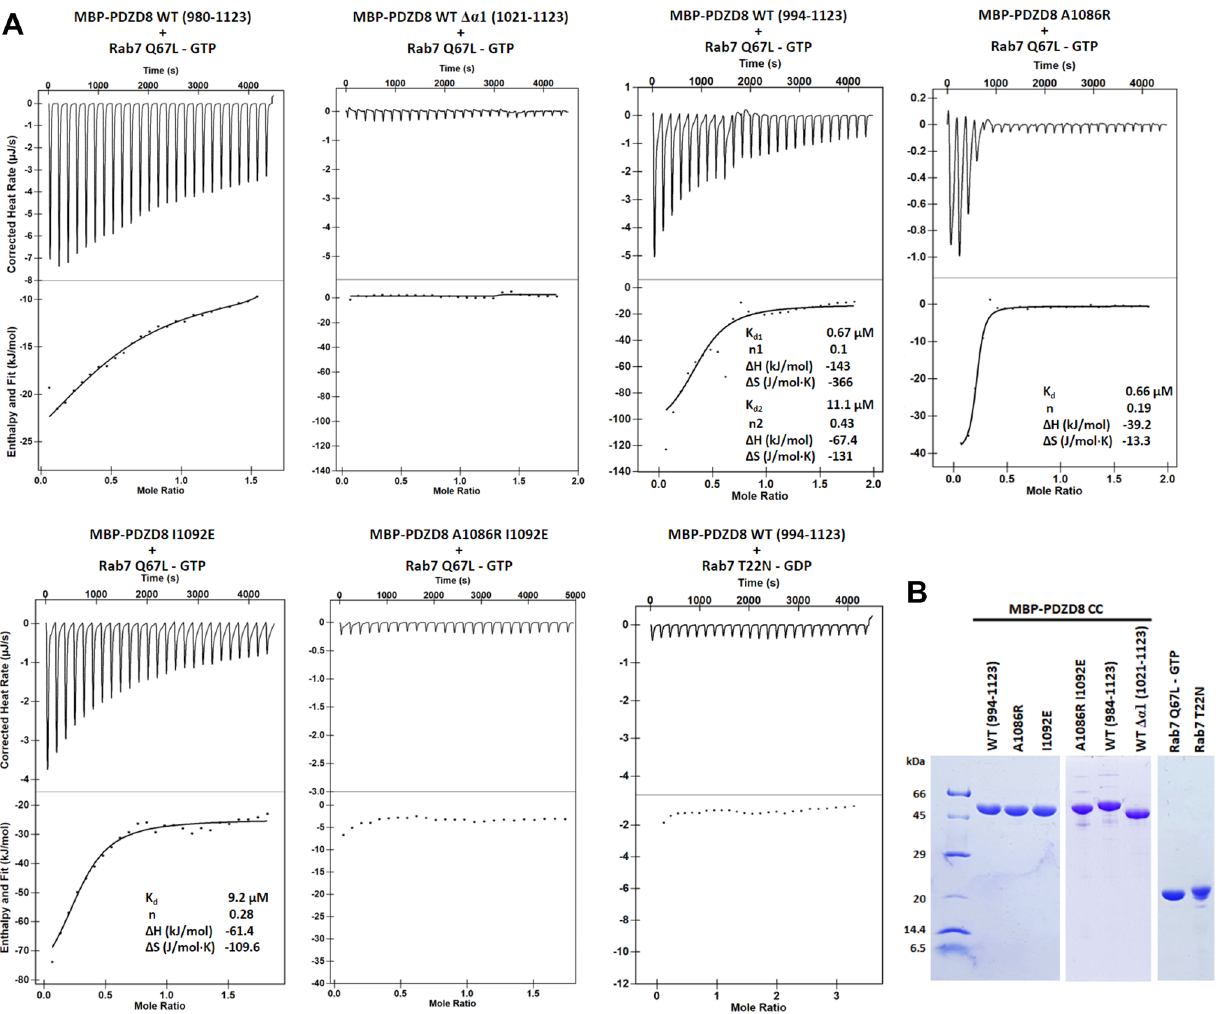
Figure 3. Affinity measurement of the PDZD8 CC and Rab7 interaction. ( A ) Measurement of binding affinity of the PDZD8 CC to Rab7 by isothermal titration calorimetry. Rab7 with a concentration of 0.1 mM was titrated with 1 mM of the MBP-PDZD8 CC constructs. The active Rab7 Q67L and inactive Rab7 T22N mutants were loaded with GTP and GDP, respectively. The ITC analysis was performed three times for each construct and a representative titration curve was shown for each construct. The other ITC results are shown in the supplementary information. ( B ) SDS-PAGE of the purified recombinant proteins used for the ITC experiments. The two gels were cropped from different parts of the same gel. The uncropped gel is shown in the supplementary different affinities and the two Rab7-binding sites are independent of each other. In addition, we tested the gua- nine nucleotide-dependency of Rab7-binding to PDZD8. The Rab7 T22N is a constitutive GDP-binding inactive mutant 17 . The PDZD8 CC wild type was unable to bind Rab7 T22N, confirming that PDZD8–Rab7 interaction is GTP-dependent. The ITC data is consistent with the structural features of the PDZD8 CC–Rab7 complex in that the switch I and II loops with active conformation serve as a binding surface for the PDZD8 CC. This observation is consistent with the previous reports that the ER/LE localization of PDZD8 is dependent on the GTP-bound Rab7 7,8 . Conservation of a binding mode in Rab7‑effector complexes. Structural comparison of the various Rab7-effector complexes suggests that the GTP-dependent interaction has a conserved mode of recognition on the active conformation of Rab7 (Fig. 4A). The hydrophobic triad on switch II and interswitch regions was first identified in Rab proteins and was proposed to be a major structural determinant for GTP-dependent effector binding and specificity 15 . So far, PDZD8 7 , RILP 18 , Rubicon 19 , and ORP1L 20 were identified to be the Rab7 effector proteins with their structures reported. The PDZD8 CC, RILP CC, and Rubicon RH domains commonly recog- nize the conserved hydrophobic triad in the switch II and interswitch regions of Rab7 14,21 . However, the ORP1L ANK domain binds on the surface distal to the switch I/II regions, explaining the nucleotide-independent inter- action of ORP1L 22,23 . The Rab7-binding domain of RILP is a coiled-coil homodimer and interacts with two